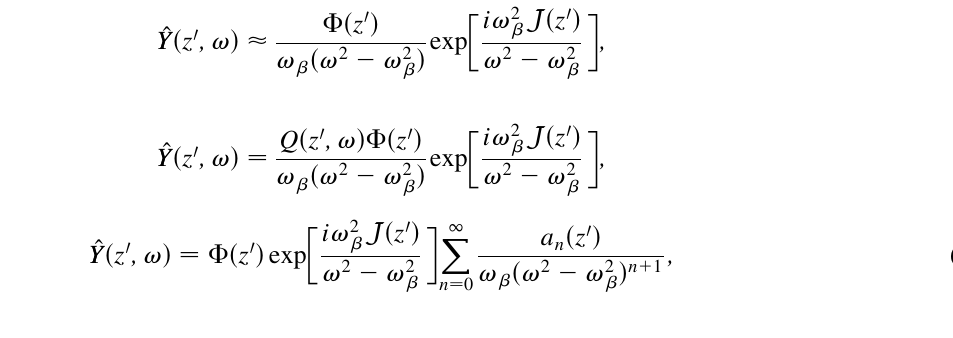
FIG. 4. The growing portion of the perturbed proton motion Y is computed using Eq. (55) with value of Y p The vertical axis has arbitrary